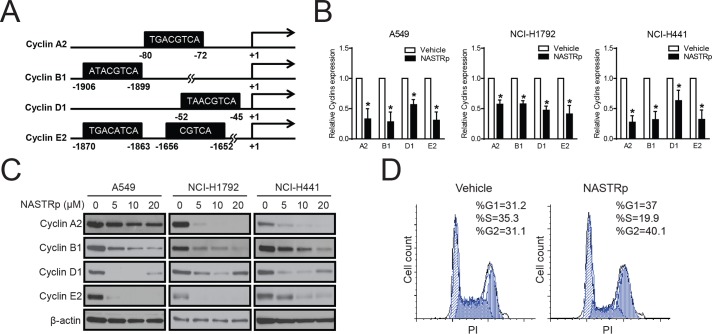
Down-regulation of Cyclins by NASTRp causes cell cycle arrest.
(A) CRE in the promoters of the cyclin genes. Sequence analysis of the promoters of the genes indicated the potential binding sites for CREB-CBP. (B and C) Effect of NASTRp of the expression of cyclins in RNA (B, qRT-PCR) and protein (C, Western blot) in A549 (left), NCI-H1792 (middle) and NCI-H441 (right). Vehicle control is set to 1 in qRT-PCR assay. For qRT-PCR data are represented as the mean ± SD of three independent experiments performed in triplicate. *P < 0.05 versus vehicle. (D) NCI-H441 cells were treated with 10 μM NASTRp for 24 hours and cell cycle distribution was determined by propidium iodide staining followed by FACS analysis.